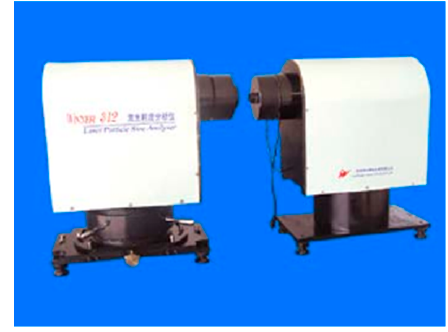
Figure 8. Laser particle size analyzer.